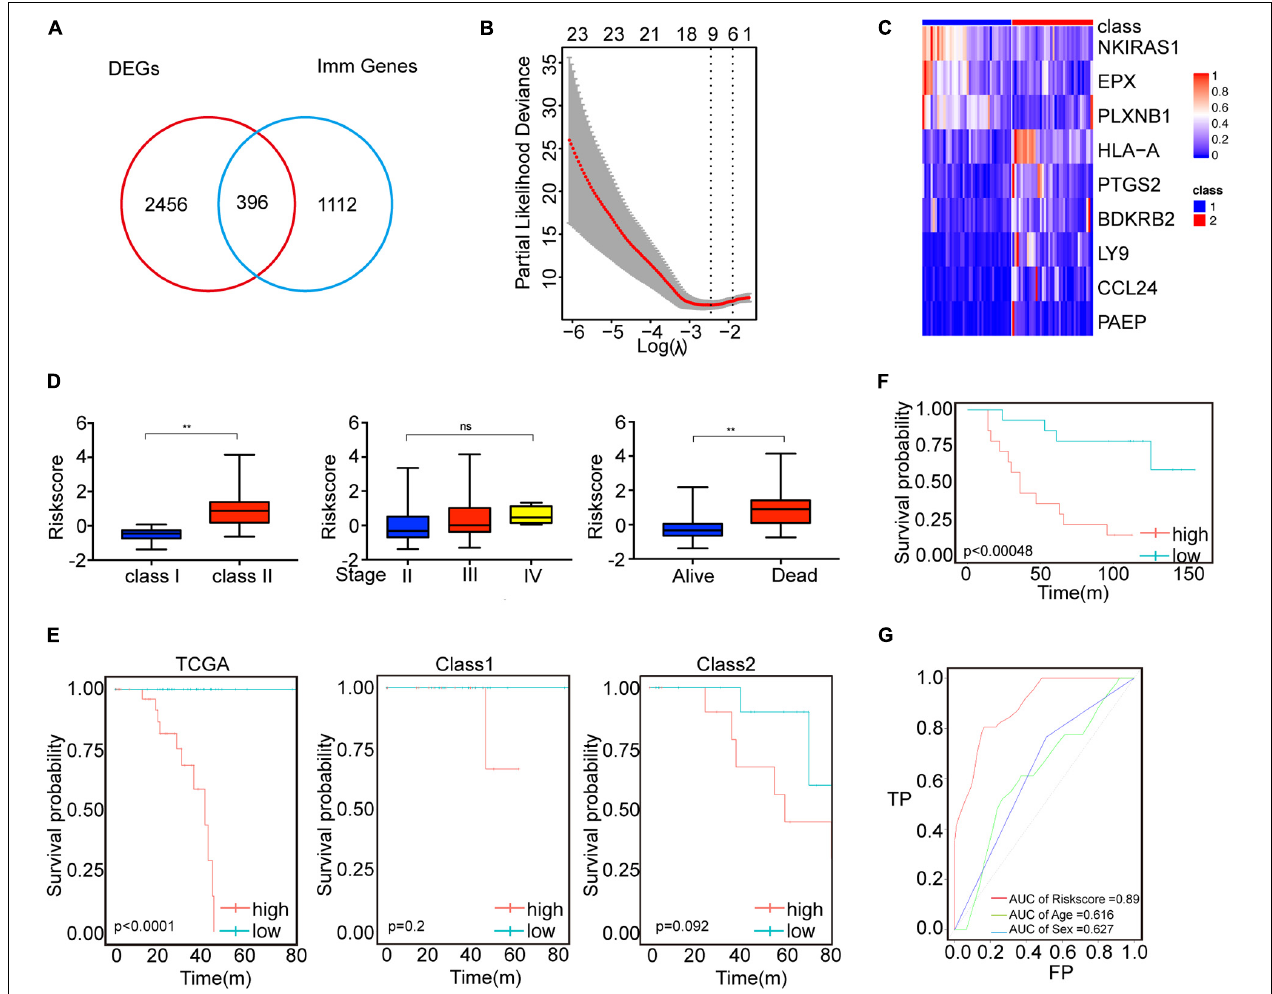
FIGURE 3 | Immune characteristics were identified by Cox proportional hazard model. (A) Venn diagram showed immune-related genes which are differentially expressed between the two immune subtypes. (B) Cross-validation for parameter selection in adjusted proportional hazard models. (C) Heatmap showed the expression level of characteristic genes. (D) Distribution of risk scores for immune subtypes, tumor stage, patient status. ** P < 0.05. (E) Survival analysis of risk scores in UVM immune subtypes. (F) Survival analysis of the risk score of GSE84976. (G) ROC curve analysis of age, sex, and immune